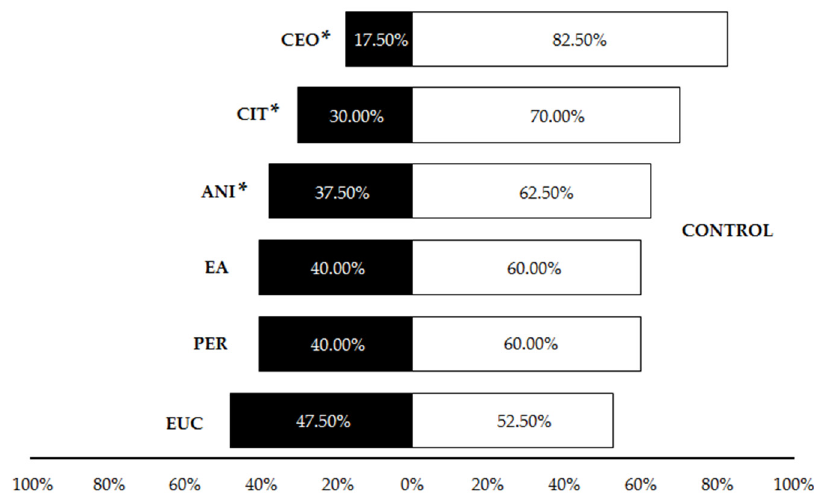
Figure 4. Percentage of Pheidole pallidula workers responding to each compound when offered simultaneously an odorless control in the olfactory tests. Asterisks (*) indicate significant differences between compounds and controls in each choice ( p ≤ 0.05). CEO: cinnamon essential oil; CIT: citronella essential oil; ANI: p-anisaldehyde; EA: ethyl anthranilate; PER: permethrin; EUC: eucalyptol.